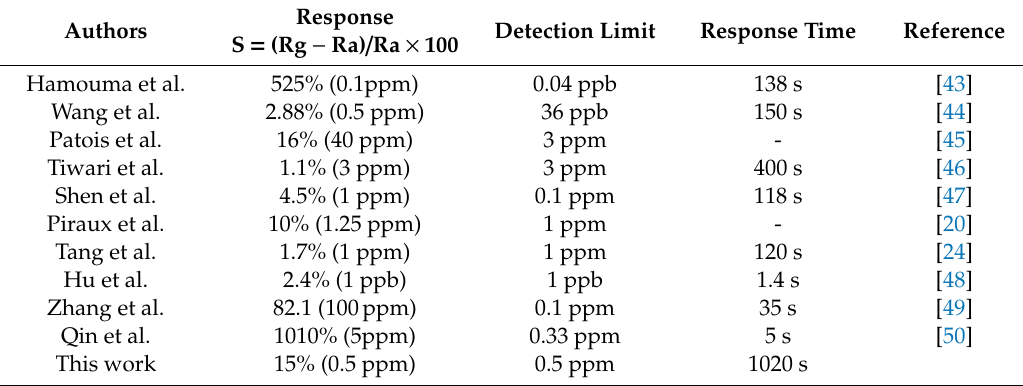
Table 3. Comparison of performance of various ammonia gas sensors based on PPy materials operating at room temperature.